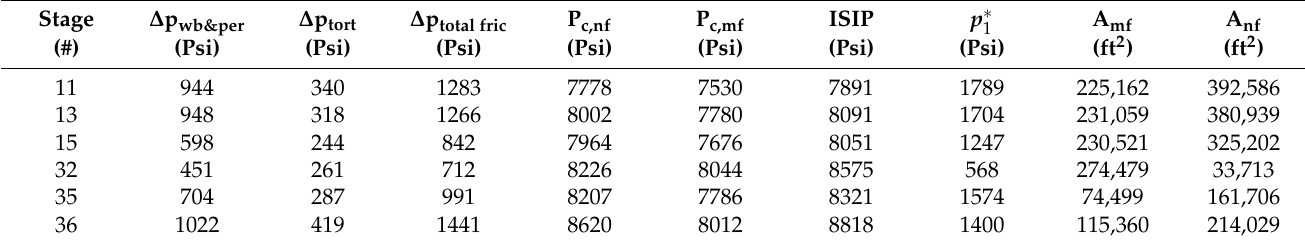
Table 13. Outcomes of pressure falloff analyses for the main hydraulic fracture treatment of